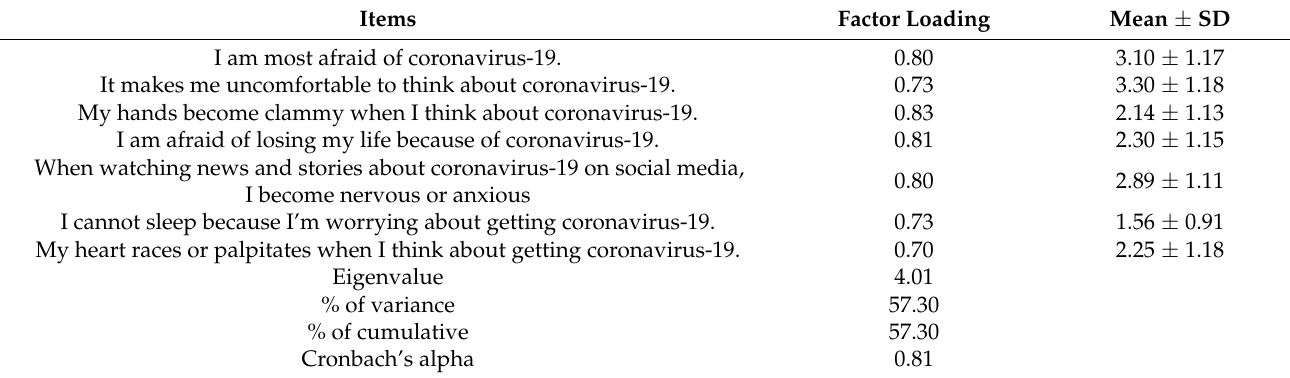
Table 2. Exploratory factor analysis of fear of COVID-19 Scale.